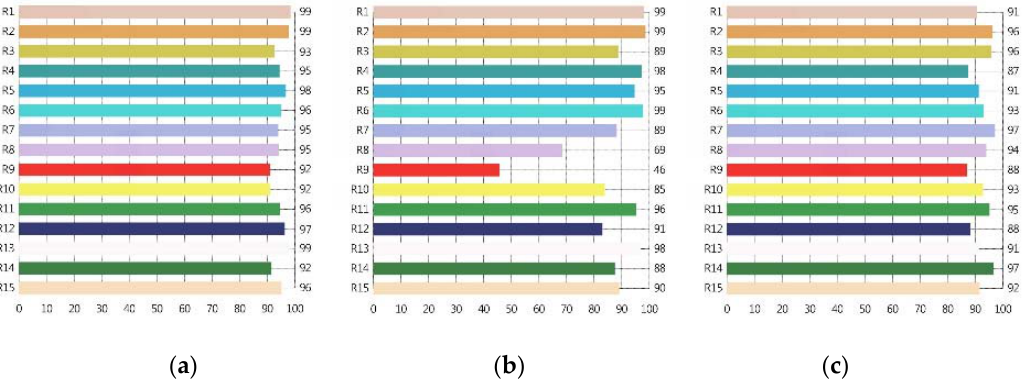
Figure 4. Colour rendering index(CRI) of three lighting environments. ( a ) Direct lighting Ra = 96, R9 = 92. The national museum of western art. ( b ) Indirect lighting Ra = 90, R9 = 46. The Aichi Prefectural museum of art. ( c ) Mixed lighting Ra = 93, R9 = 88. The Yamazaki Mazak museum of art.